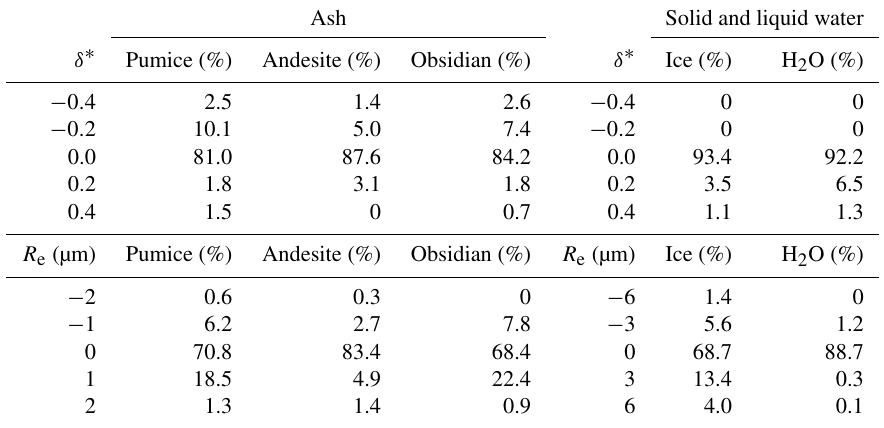
Table 1. Five central bins of the distributions of the differences (VPR retrievals minus true values) for the optical depth and the effective radius, obtained from the simulations performed for the Sicilian Mt. Etna volcano cases. Ash Solid and liquid water δ ∗ Pumice (%) Andesite (%) Obsidian